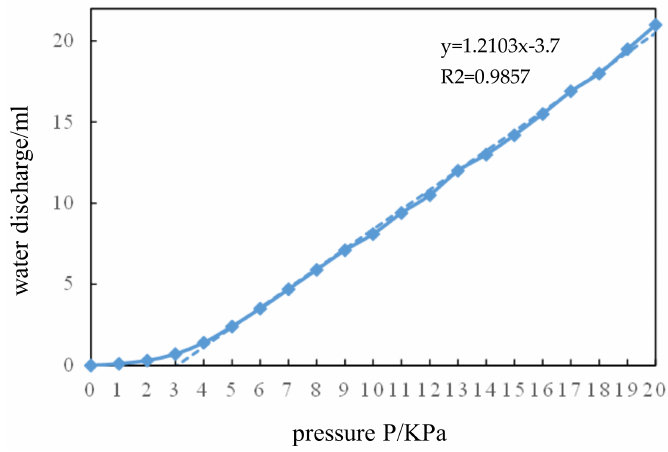
Figure 11. Relationship between pressure input and water discharge in direct ventricular assist devices. (R2 =